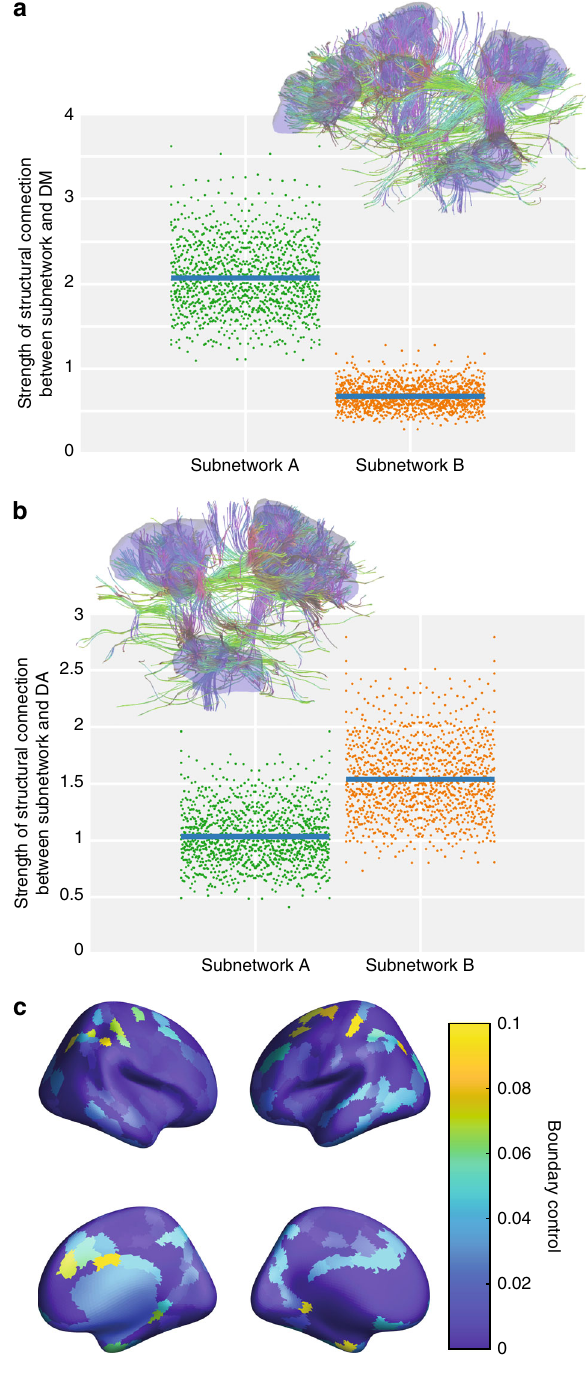
Fig. 2 White matter connectivity of the frontoparietal